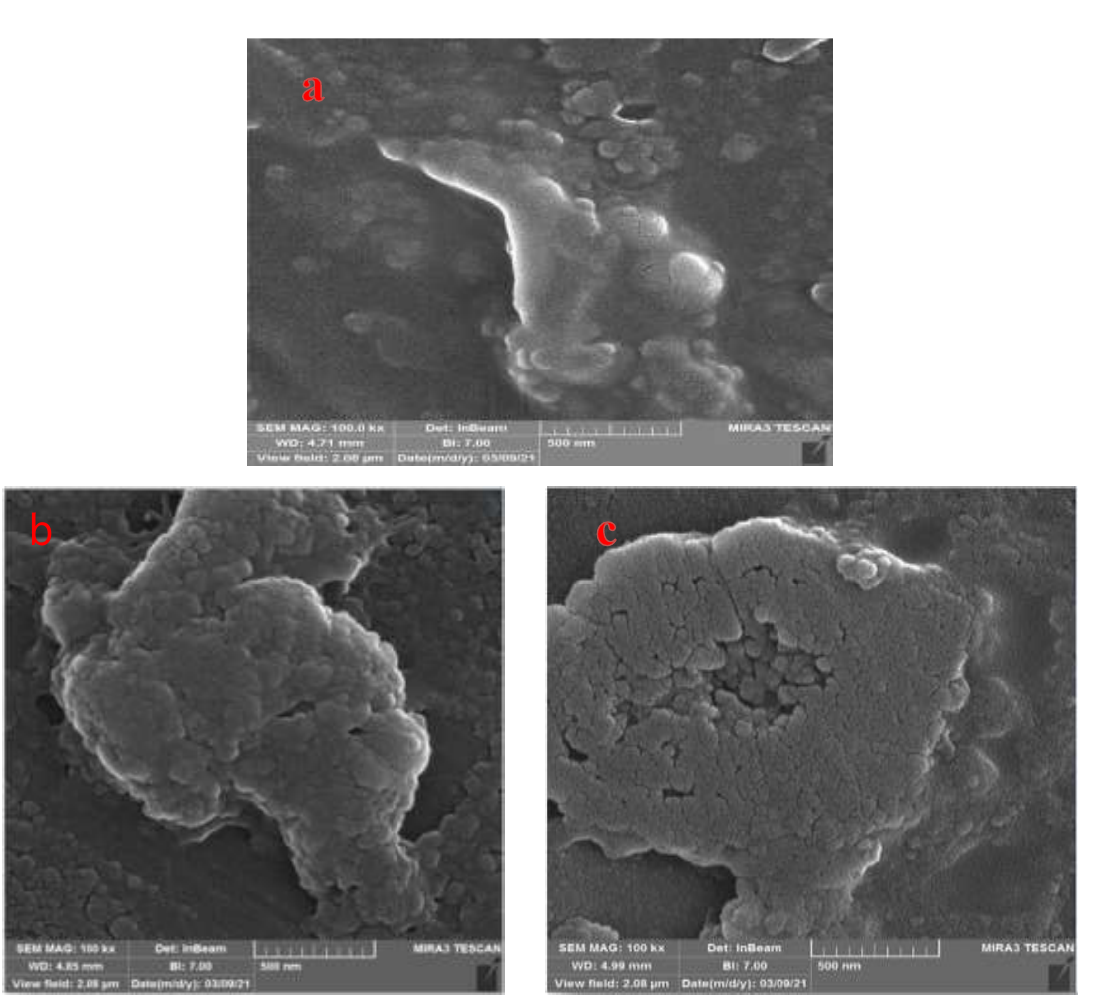
Figure 6: FE-SEM micrographs of TiO 2 NPs synthesised with laser energy of (a) 80 mJ, (b) 120mJ, and (c) 160mJ at 100